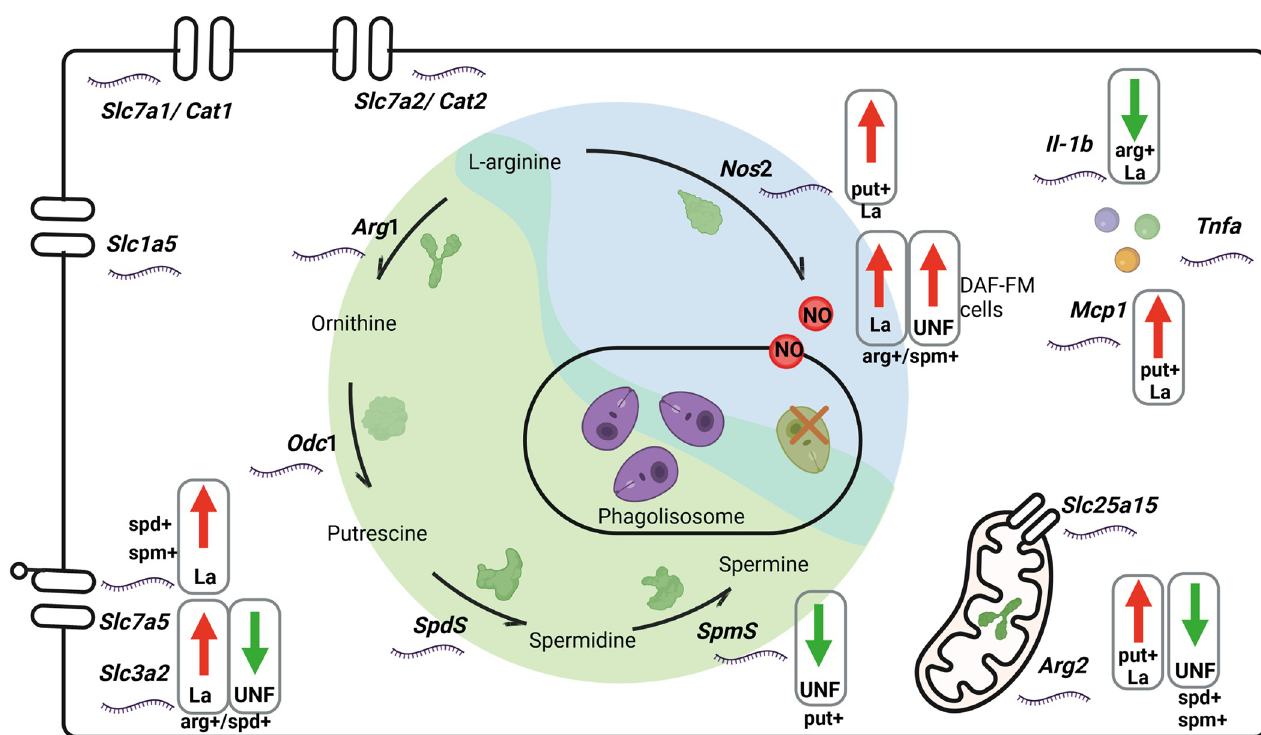
Fig 6. Effects of L-arginine and polyamines supplementation in gene expression in BALB/c macrophage during infection with L . amazonensis . Genes modulated by putrescine, spermidine, spermine, or L-arginine. The L-glutamine transporter SLC1A5 is shown in the mitochondrial membrane. SLC25A15 performs the L-citrulline and L-ornithine antiport between the mitochondria and cytosol. The enzymes from polyamines biosynthesis: arginase 1 (ARG1) converts L-arginine into ornithine, which is subsequently converted by ornithine decarboxylase 1 (ODC1) into putrescine. Putrescine is converted by spermidine synthase (SPDS) into spermidine; spermidine is converted by spermine synthase (SPMS) into spermine. The Nitric oxide 2 (NOS2) enzyme uses L- arginine to produce nitric oxide (NO) and citrulline. Also, mitochondrial arginase 2 (ARG2) uses L-arginine to produce ornithine. E, extracellular environment. The L-arginine transporters CAT1 and CAT2 and the heterodimeric amino acid and polyamines transporter SLC3A2/SLC7A5 are shown in the plasmatic membrane. The amino acid and polyamines transporters can also mediate transport in the phagolysosome membrane. Created with Biorender.com.